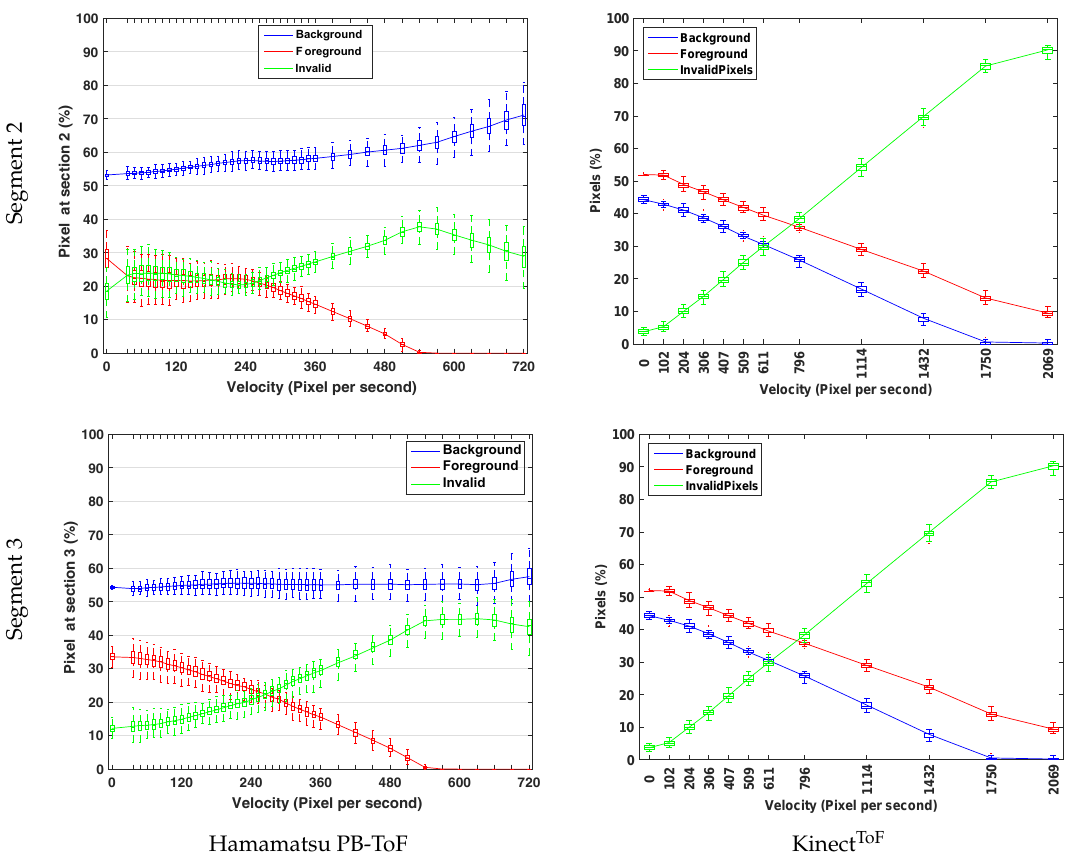
Figure 10. Turning Siemens star: Motion artefacts statistics for the Hamamatsu PB-Tof camera ( left column ) and the Kinect ToF -camera ( right column ) for section 2 (top row) and 3 (bottom row)